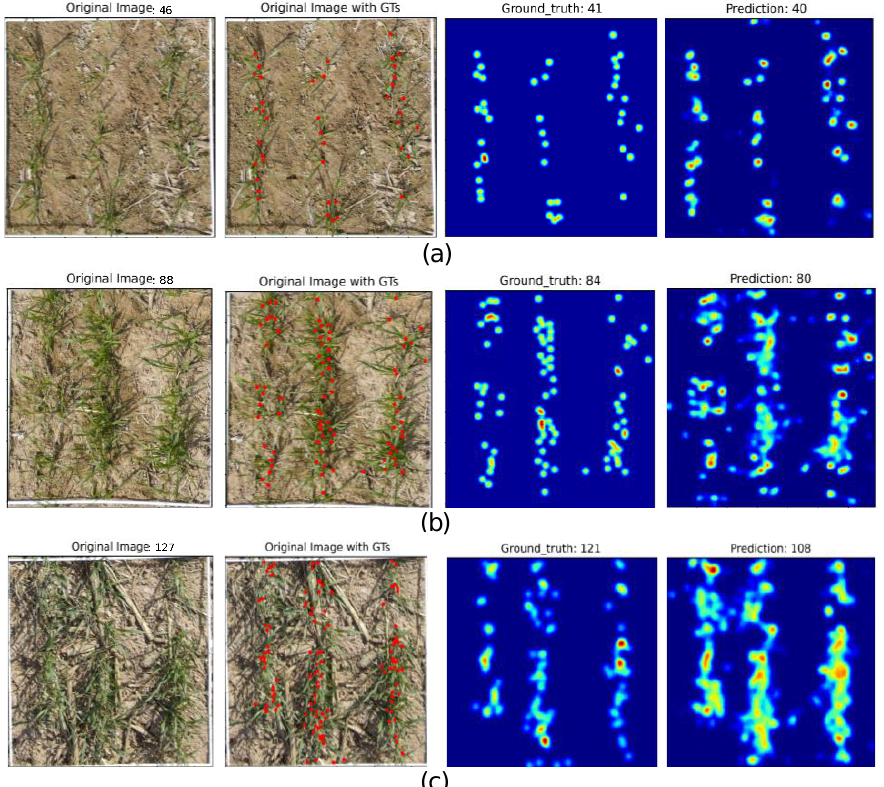
Figure 9. Examples of wheat plant density estimation on the test dataset with different density levels: ( a ) low, ( b ) moderate, and ( c ) high plant density levels. The model results with various zenith angles presented significant differences (Table 6). With the low altitude of the UAV flight, the pixels on the UAV images had various zenith angles. For each quadrat, the UAV image was repeated nine times at nine specific